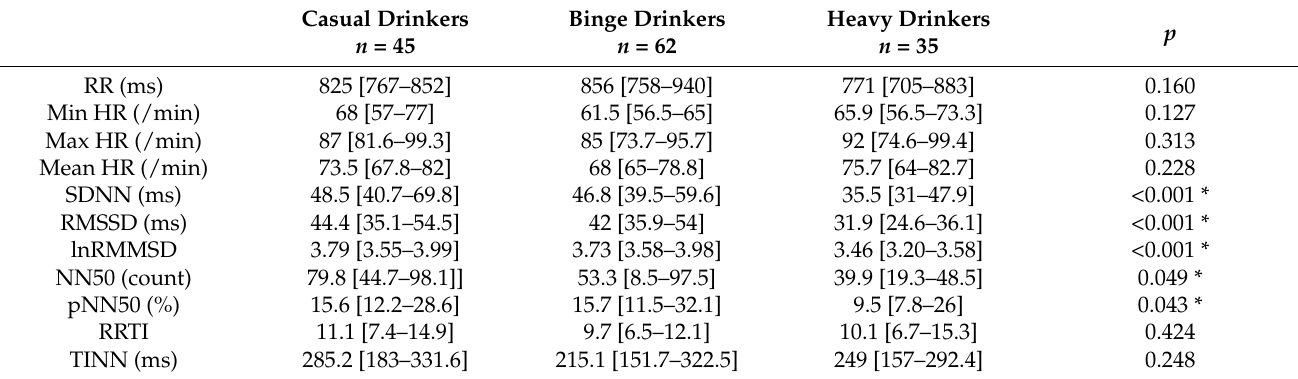
Table 3. HRV–time-domain analysis ( n =